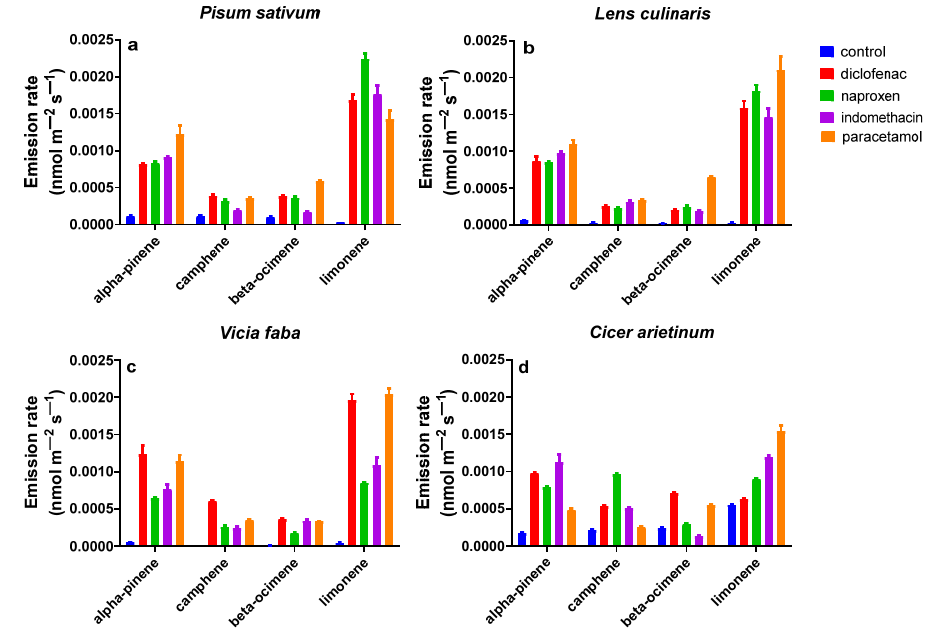
Figure 3. The emission rates of monoterpenes from leaves from Pisum sativum ( a ), Lens culinaris ( b ), Vicia faba ( c ), and Cicer arietinum ( d ). Plants in 0.5 L pots filled with commercial garden soil were treated by watering 100 mL of 0.5 mg L − 1 NSAIDs every second day over a total of 20 days. The values are averages of three independent